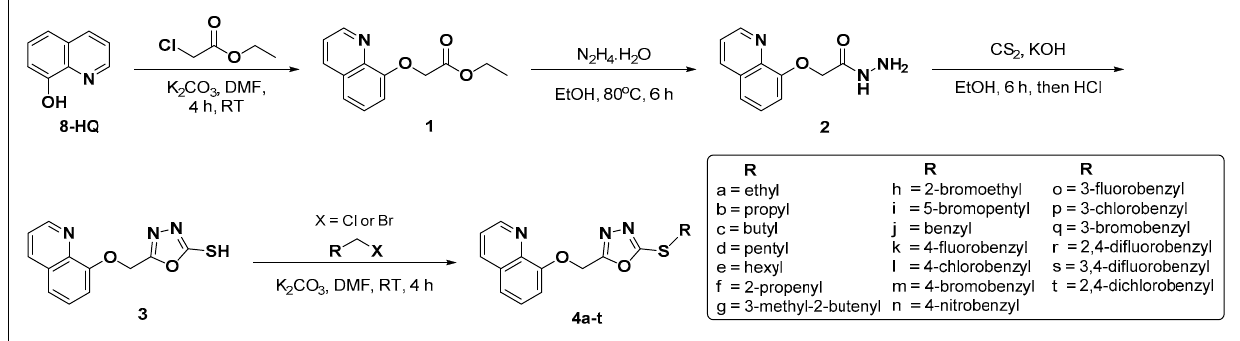
Figure 1. Reported α -glucosidase inhibitors based on quinoline, 1,3,4-oxadiazole, and 1,2,3-triazole cores.